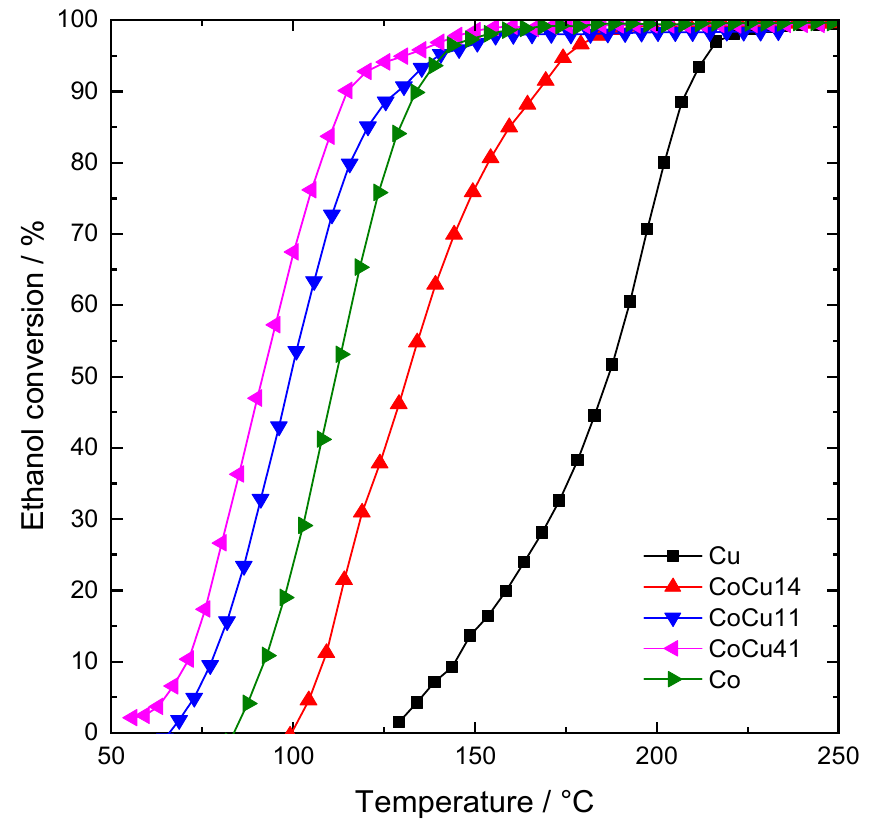
Figure 7. Light-off curves of ethanol oxidation over the examined catalysts. Table 6. Catalytic properties of the examined Co-Cu oxide catalysts (oxidation of 750 ppm of etha- nol in air at GHSV of 20 l g cat–1 h –1 ).